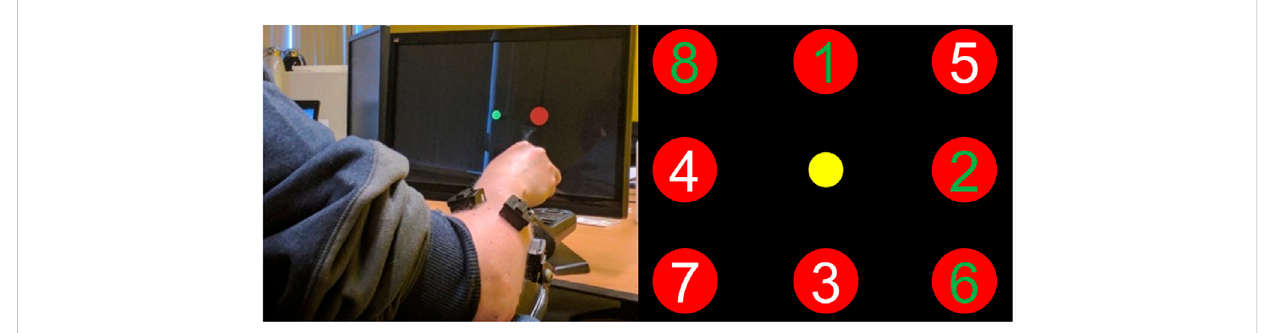
FIGURE 1 On the leftside, theparticipant with Duchenne muscular dystrophy controlling a virtual cursor in 1 and 2 degrees-of-freedom, while resting his arm onhiswheelchair. ThewirelessEMGbipolarelectrodescanbeseenaroundhisforearm.Ontherightside,thelocations ofallpossibletargets(red)shown by their target number, and the cursor (yellow). Targets 1-4 are part of the 1-DOF trials and targets 5-8 of the 2-DOF. Each trial accepted as successful when participant kept the cursor inside the target for 2 s. The trials with a green number (1,2,6, and 8) are those performed by the individual with